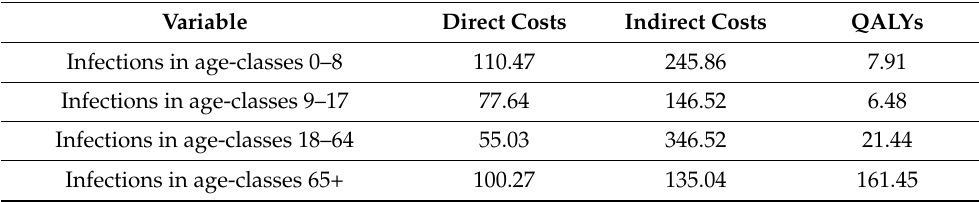
Table A11. Linear regression